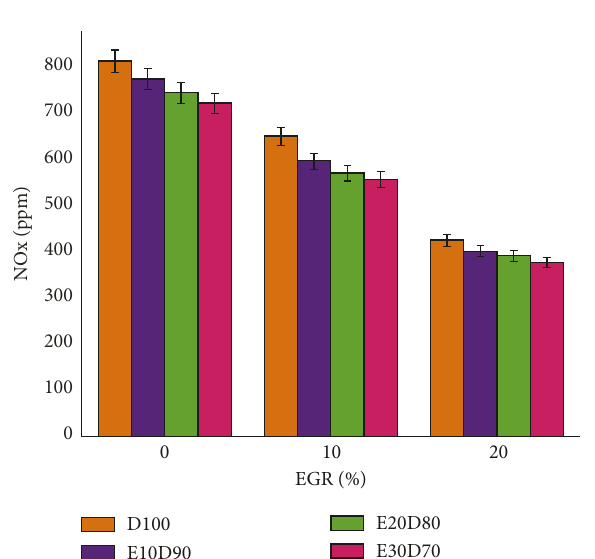
Figure 16: Variation in NO load.